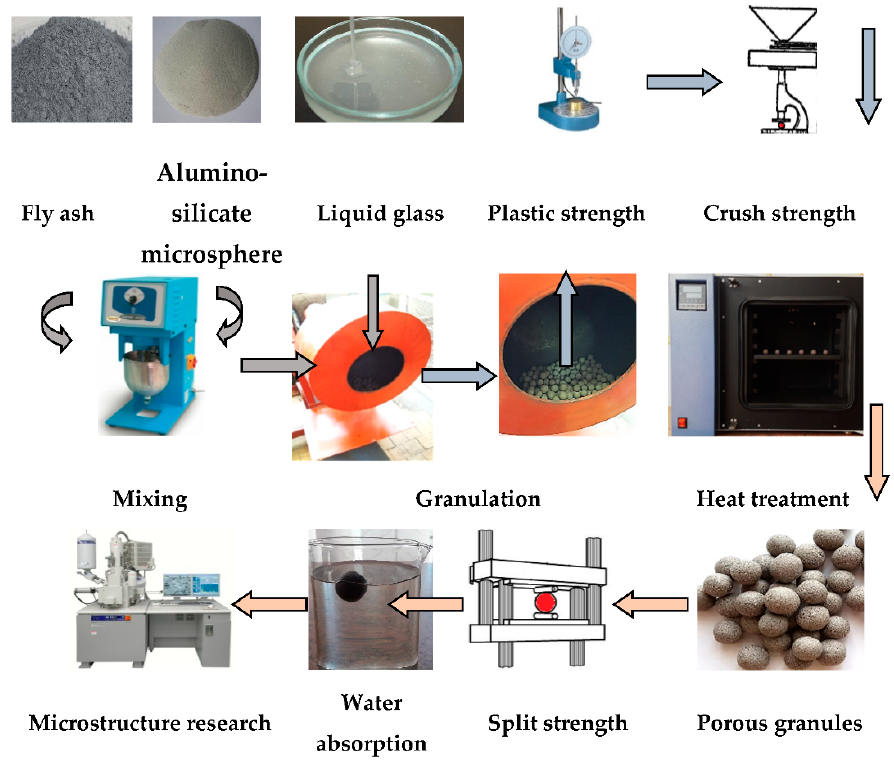
Figure 3. Flowchart of research of properties of granules.